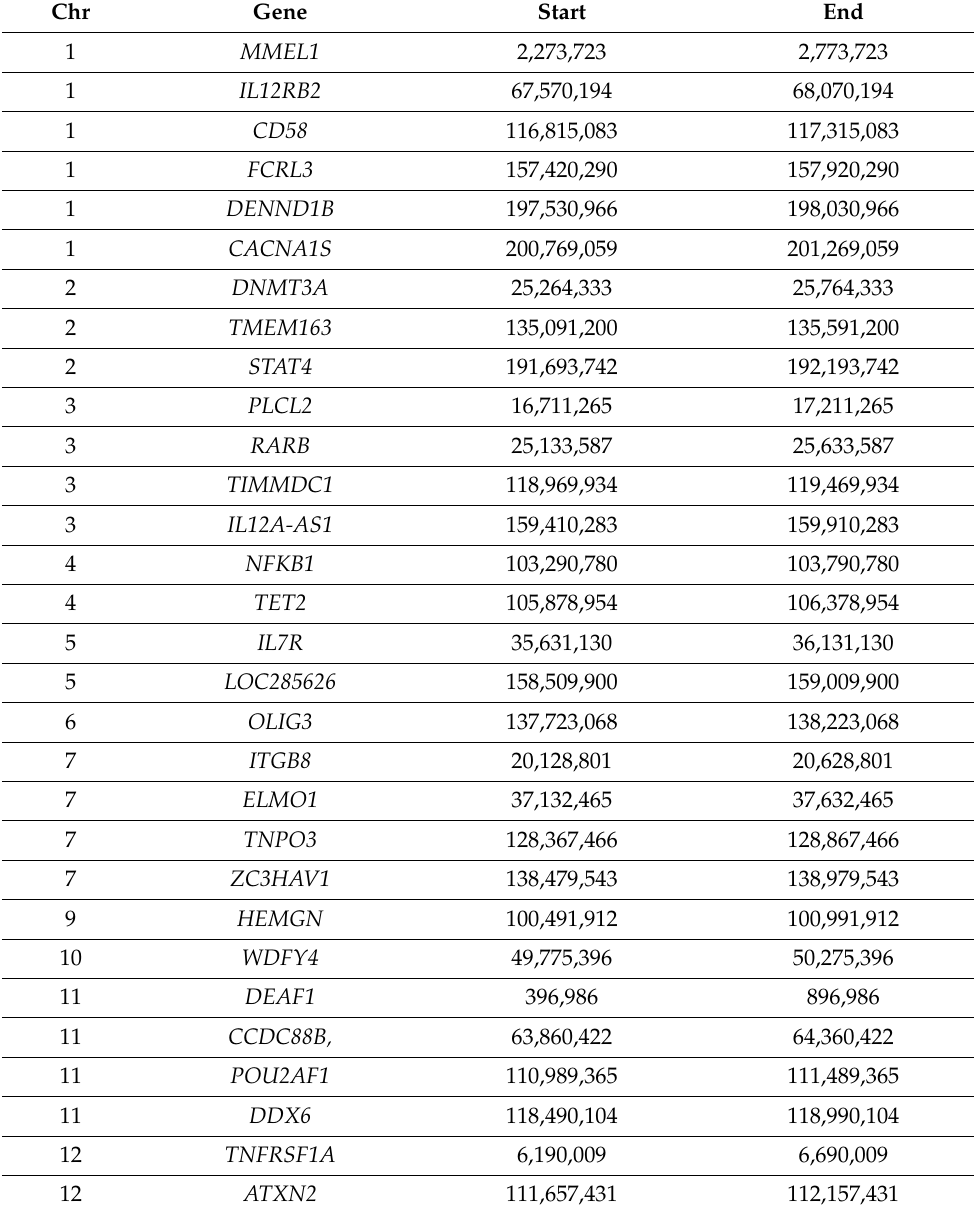
Table 1. Selected loci at genome-wide significant threshold in